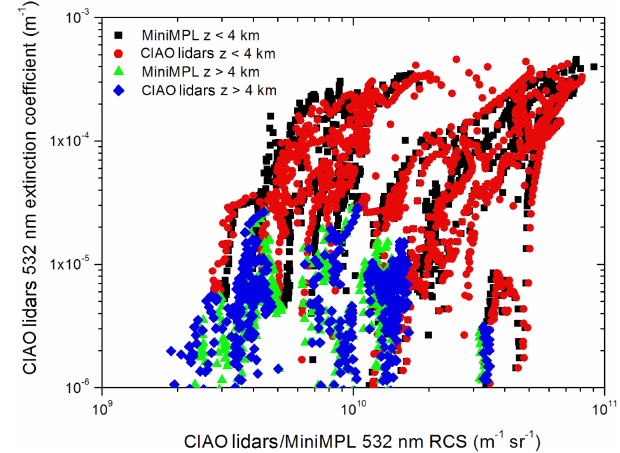
Figure 7. Comparison of the scatter plots showing the relation- ship between CIAO lidars 532nm aerosol extinction coefficient and MiniMPL and CIAO lidars 532nm RCS. Black squares are the val- ues of MiniMPL measured below 4km, green triangles are the val- ues of MiniMPL measured above 4km, red squares are the values of CIAO lidars measured below 4km and blue diamonds are the values of CIAO lidars measured above